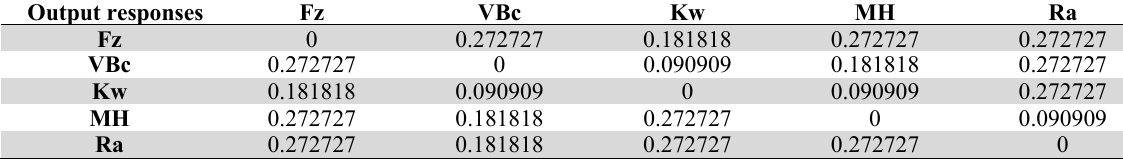
Normalized values for the direct-relation matrix